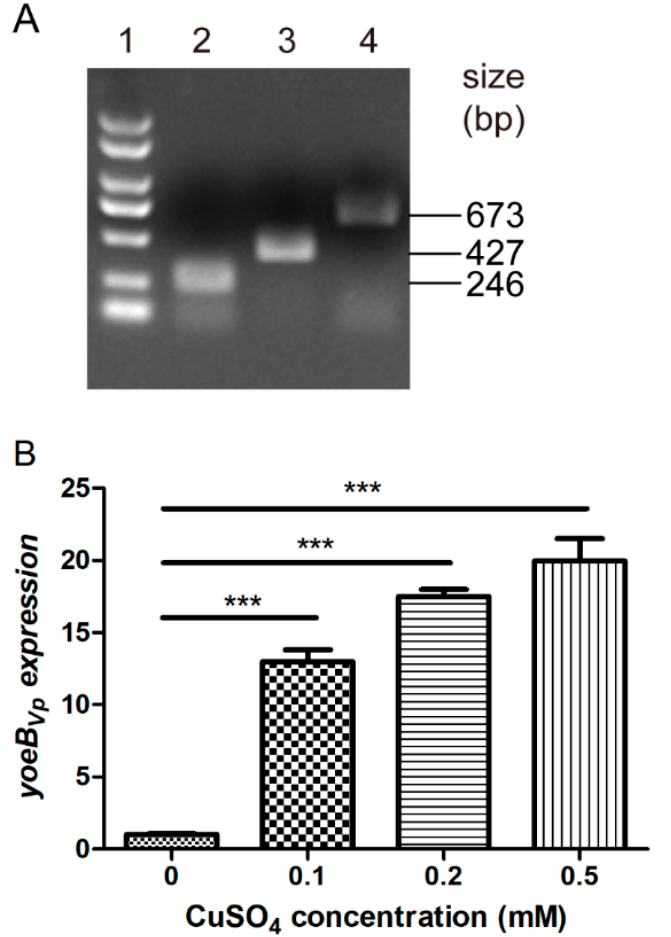
Figure 1. Identification of the S. suis strain expressing the copper-inducible YoeB Vp toxin. ( A ) PCR identification of the SC19/pSET2-P copA - yoeB Vp strain. Lane 1 indicates the DL2000 DNA marker. Lanes 2–4 indicate PCR amplification of the P copA promoter, the yoeB Vp gene, and the P copA - yoeB Vp construct, respectively. ( B ) RT-qPCR identification of the SC19/pSET2-P copA - yoeB Vp strain. The data shown are the means and standard deviations (SD) from three independent experiments. One-way analysis of variance with Bonferroni’s post-test was used for statistical analyses. *** indicates p <